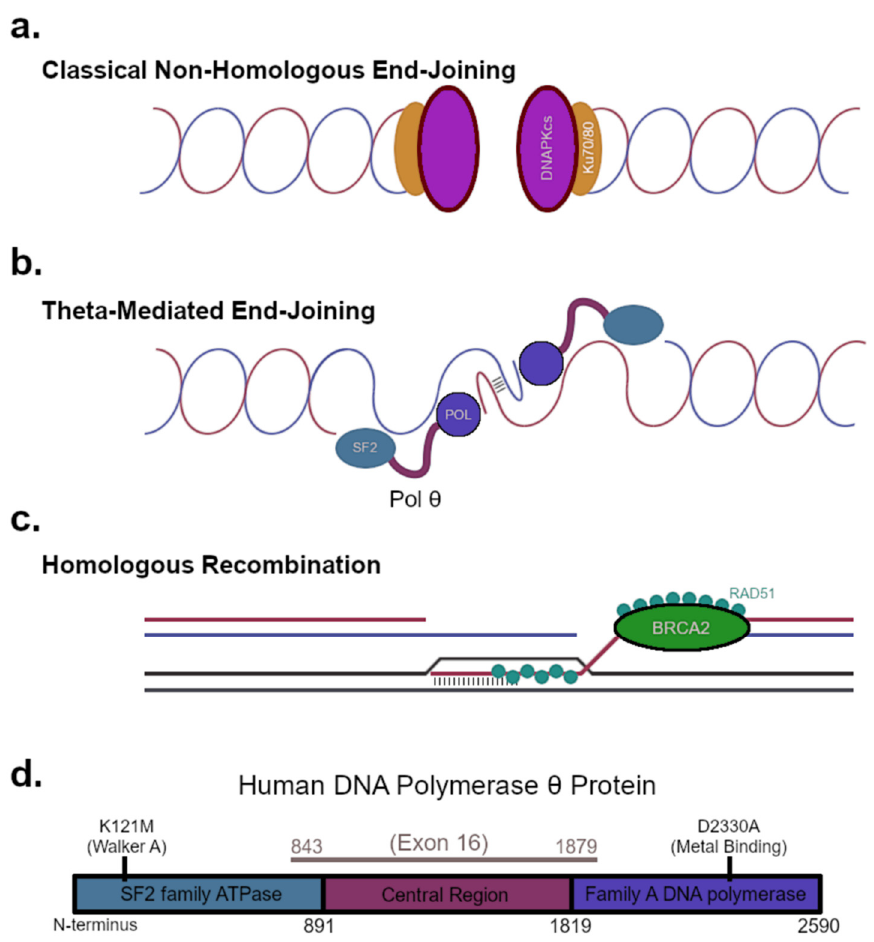
3 (cid:48) -overhangs (Figure 1c). BRCA1 also regulates the first steps of the 5 (cid:48) -end resection [8]. The RAD51-ssDNA filament then initiates a homology search, forming a displacement- loop (D-loop) as it invades the sister chromatid. The D-loop establishes a primed 3 (cid:48) -end for extension by DNA polymerases, followed by second-end capture, Holiday junction resolution and ligation.